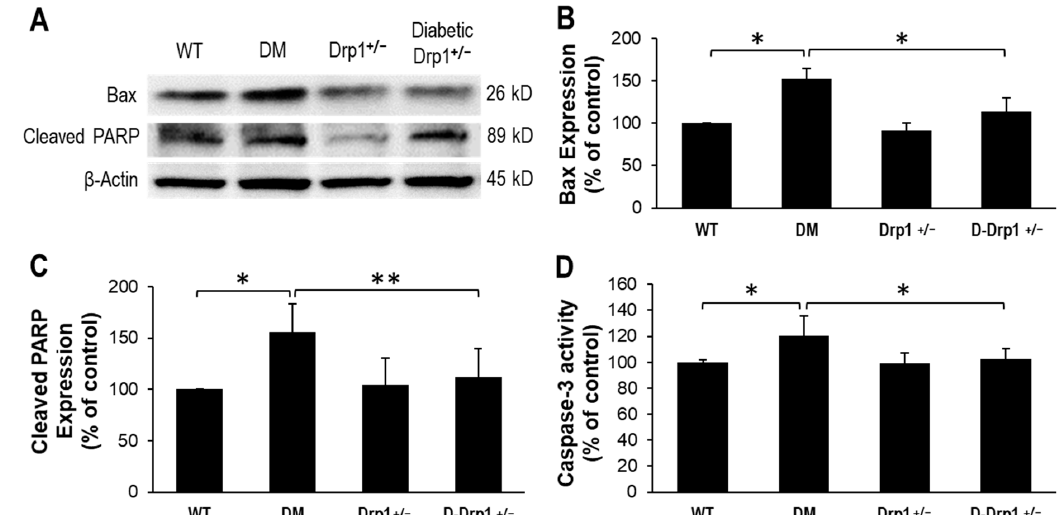
Figure 4. Reduced Drp1 expression lowers Bax activity in diabetic Drp1 +/ − mouse retinas. ( A ) Representative WB image shows Bax and cleaved PARP expression in the retinas of WT, diabetic (DM), Drp1 +/ − , and diabetic Drp1 +/ − (D-Drp1 +/ − ) mice. Graphical illustrations of cumulative data suggest reduced Drp1 levels in D-Drp1 +/ − mice is protective against diabetes-induced increase in ( B ) Bax levels, ( C ) PARP cleavage and ( D ) caspase-3 activity. Data are expressed as mean ± SD. * p < 0.01, n = 12; ** p < 0.05, n = 12.